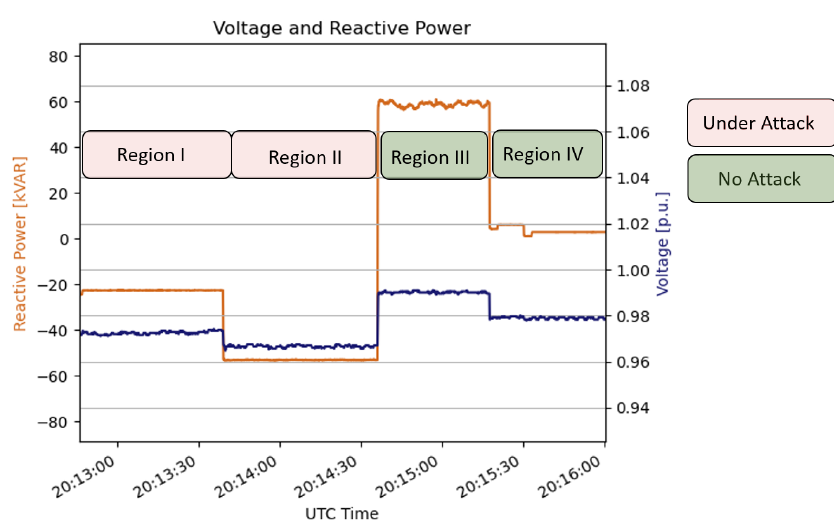
Figure 4. The adverse affects of a malicious Volt-VAR curve are shown in Regions I and II. Region III shows the effects from using a traditional Volt-VAR curve. Region IV shows the system voltage with no reactive power